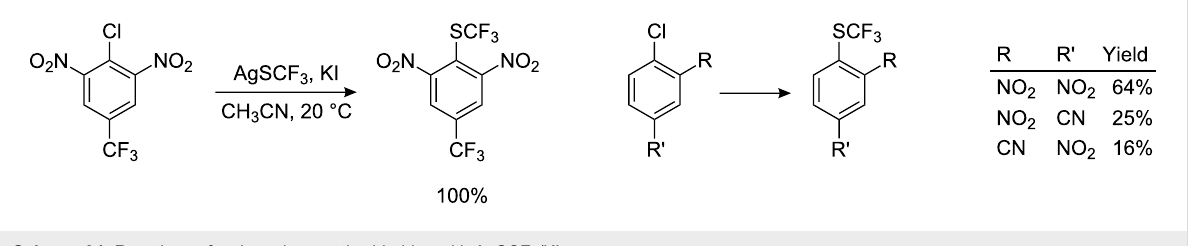
Scheme 34: Reactions of activated aromatic chlorides with AgSCF 3